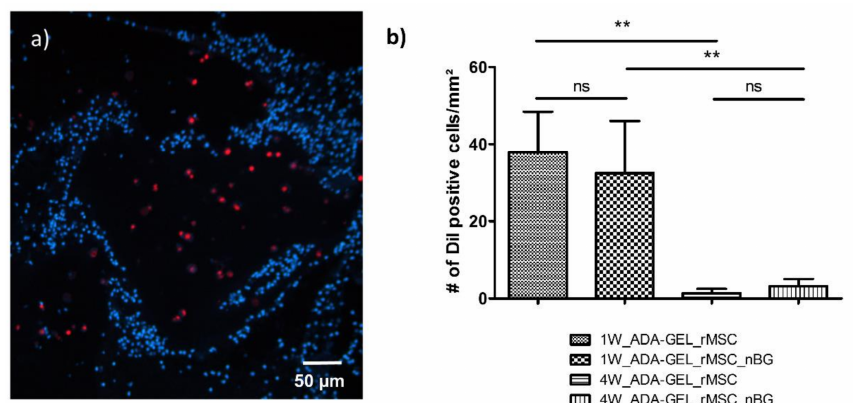
Figure 2. ( a ) Representative image 1 week after implantation (1W_ADA-GEL_rMSC). DiI (DiI cell tracker, Life Technologies, Darmstadt, Germany) -labeled rMSCs (red) are easily detectable within beads, and their nuclei are clearly co-stained with DAPI (blue), proving their viability; ( b ) Mean total number of DiI positive cells per mm 2 (mean ± SD). A marked decrease was noted after 4 weeks, compared to cell survival after 1 week. ns: not significant, ** p ≤ 0.01 (Mann Whitney U